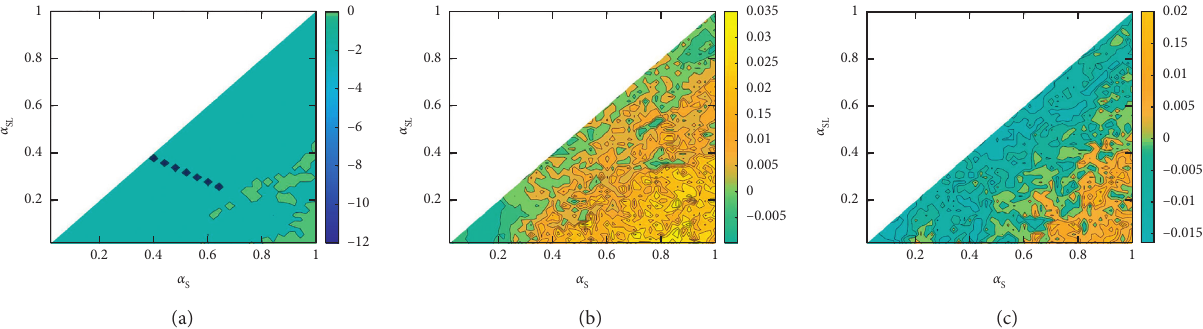
Figure 11: LLE diagram of supply chain nodes under the scenario of random demand obeying uniform distribution from the global � 4. (a) The retailer’s LLE chart. (b) The LLE chart of the distribution center. (c) The LLE chart of the perspective when G d � 1 and G 2 combined system from the decision perspective.